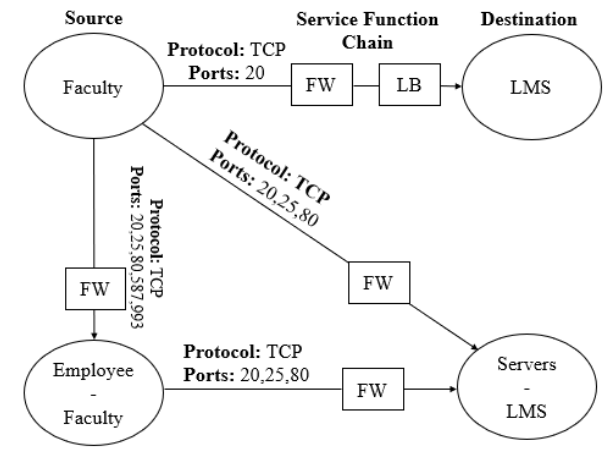
Figure 2. Graph Composition of Policies (P 1 , P 2 , P 3